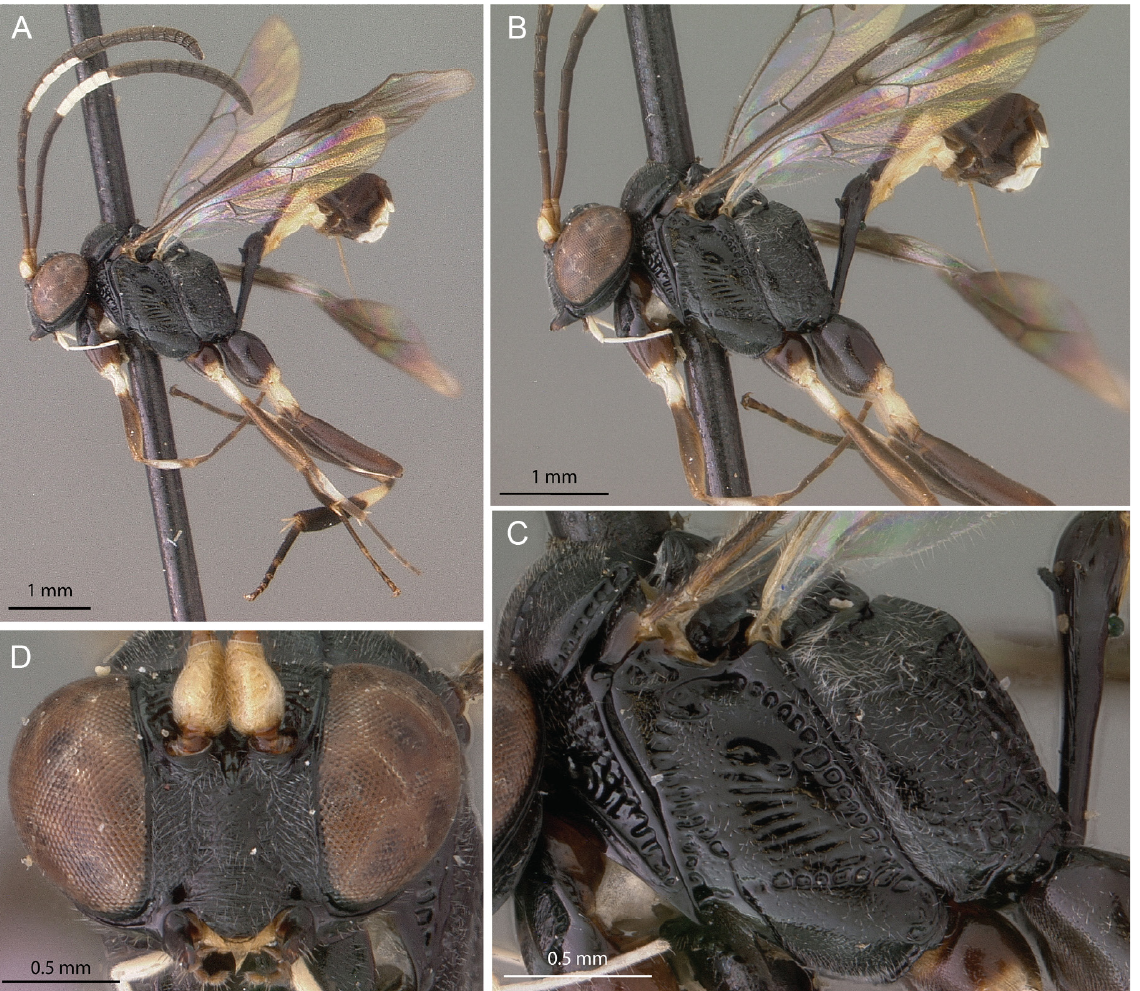
Fig. 28. Palpostilpnus striator (Aubert, 1961), holotype, ♀ (USUC) . A–B . Lateral habitus. C . Meso- pleuron. D . Head, anterior